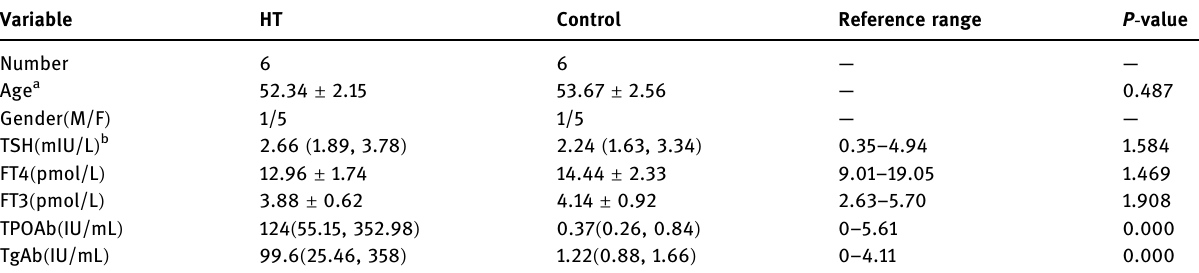
Table A2: The clinical characteristics of patients with Hashimoto ’ s thyroiditis and controls used in